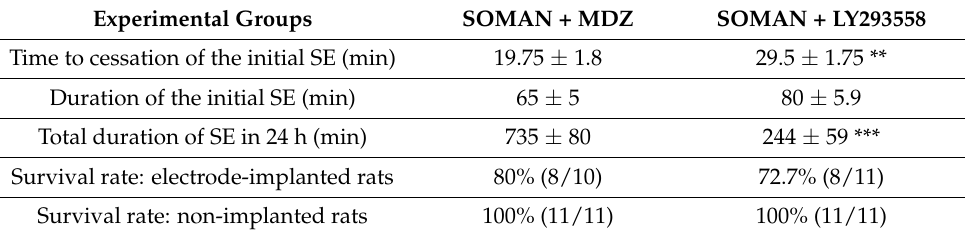
Table 1. Effects of MDZ (5 mg/kg, i.m) or LY293558 (10 mg/kg, i.m) on soman-induced status epilep- ticus (SE) and survival rate, when the anticonvulsants are administered 1 h after soman